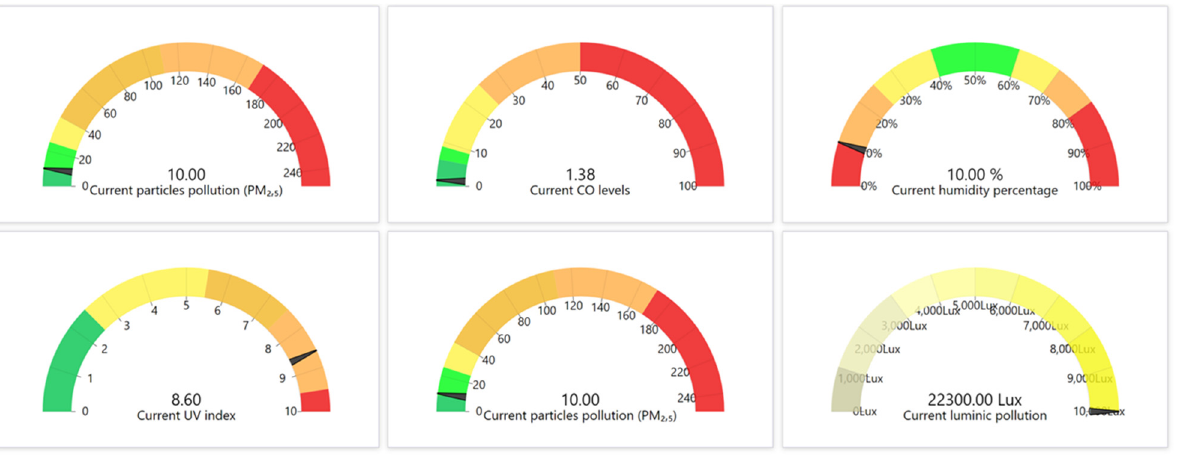
Figure 5. Comparison of several years (one per line) with the maximum temperatures reached for each of the weeks of the year in the same region. It is worth highlighting that the represented values consist of the mean of multiple sensor measurements (coming from various environments like pri- vate houses, buildings, streets, etc.) and is disposed in the Fahrenheit scale . The fourth dashboard (Figure 6) is aimed at monitoring pandemics, for which infor- mation has been taken from the recent COVID19 pandemic. It consists of a SIRD model that allows the prediction of the evolution of the pandemic using a probabilistic mathe- matical model, adaptable to any future scenario with another disease that expands in a specific population.